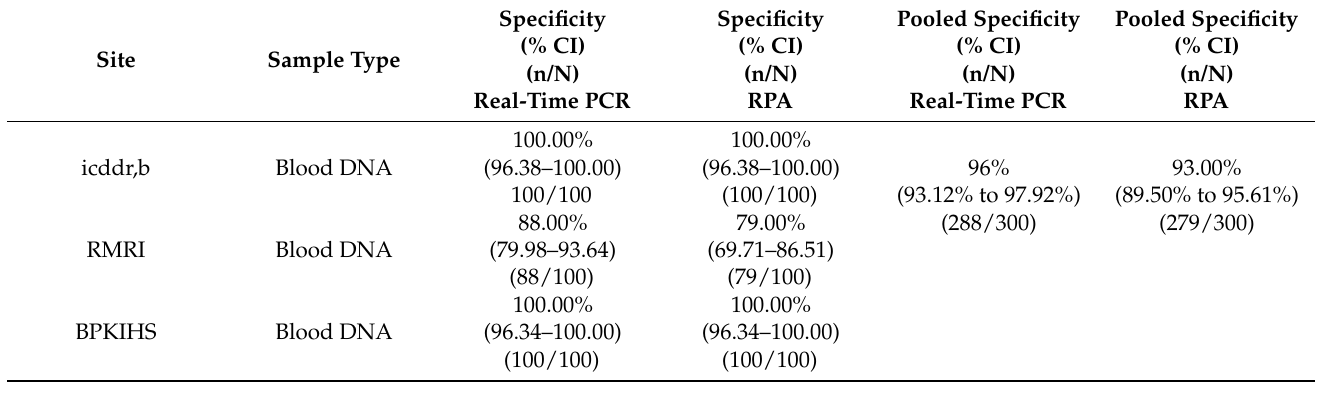
Table 3. Specificity determination of both real-time PCR and LD RPA assay in diagnosis of VL and PKDL.